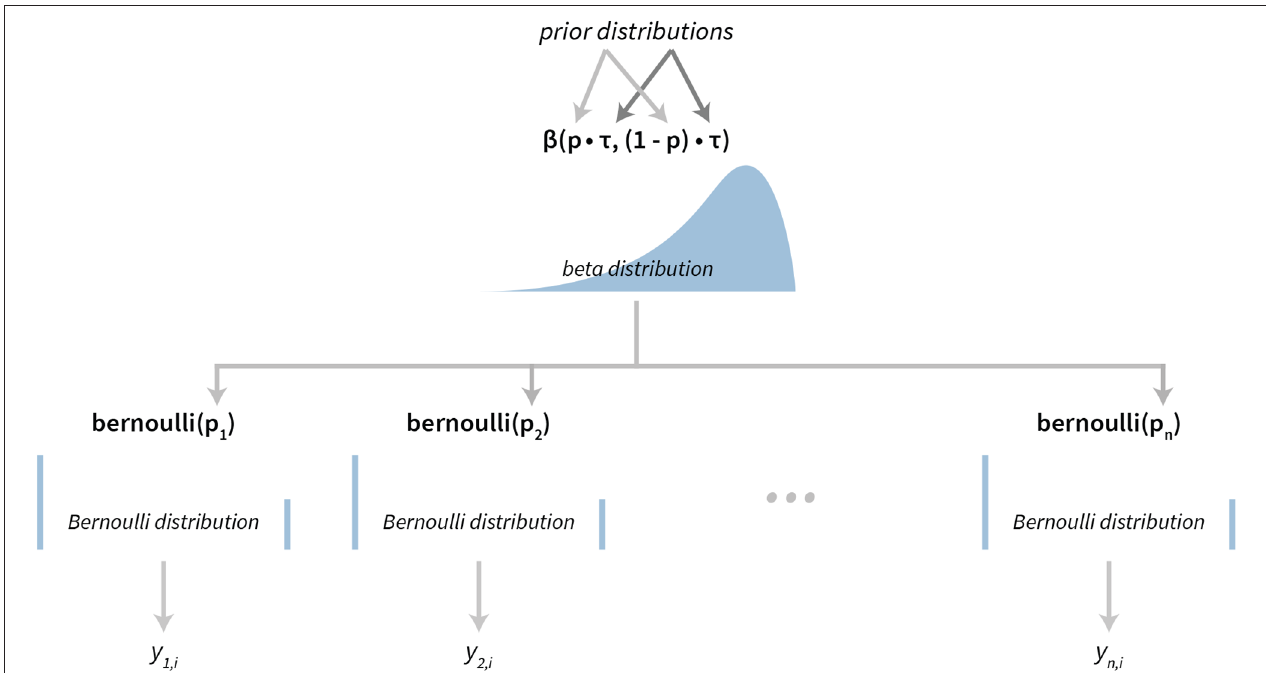
FIGURE 3 | The visualization of the Bayesian success rate model. The model has a hierarchical structure. Data about success of individual subjects ( y n , i depicts success on the i -th attempt of the subject n ) are used for inferring Bernoulli distributions on the subject level. Parameters of subject level distributions are then connected at the group level with a Beta